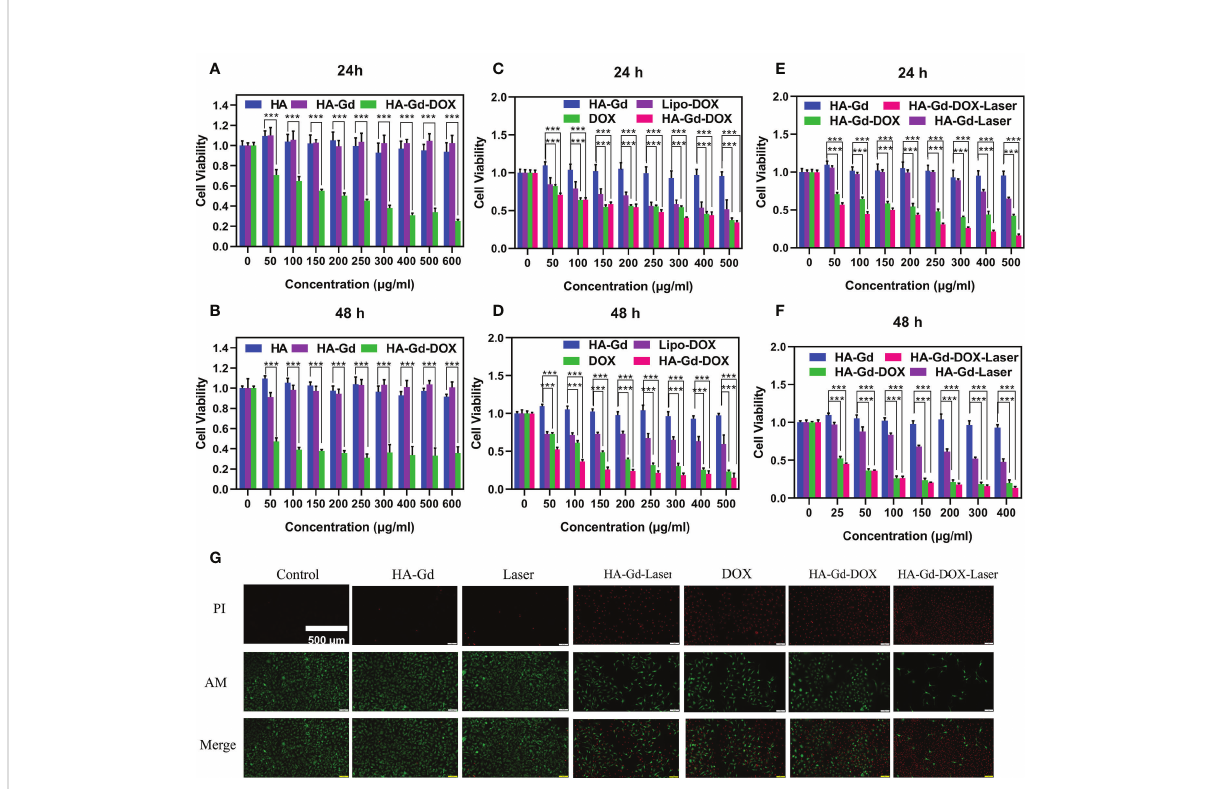
FIGURE 4 Cell viabilities of A549 treated with different concentrations of HA, HA-Gd, and HA-Gd-DOX for 24 h (A) and 48 h (B) . Cell viabilities of A549 treated with different concentrations of DOX, Lipo-DOX, and HA-Gd-DOX (corresponding amount of DOX) for 24 h (C) and 48 h (D) . Cell viabilities of A549 treated with HA-Gd, HA-Gd+laser, HA-Gd-DOX, and HA-Gd-DOX+laser at different concentrations for 24 h (E) and 48 h (F) . Data are mean ± SD ( n = 5, * p < 0.05, ** p < 0.01, *** p < 0.001; the signi fi cance of experimental results was analyzed by two-tailed Student ’ s t -test). (G) Live – dead staining images of A549 cells treated with different treatments, the concentration of HA-Gd-DOX is 400 m g/ml, and the laser is irradiated with an 808-nm laser 5 min on 1.0 W/cm 2 . Scale bars are 500 m